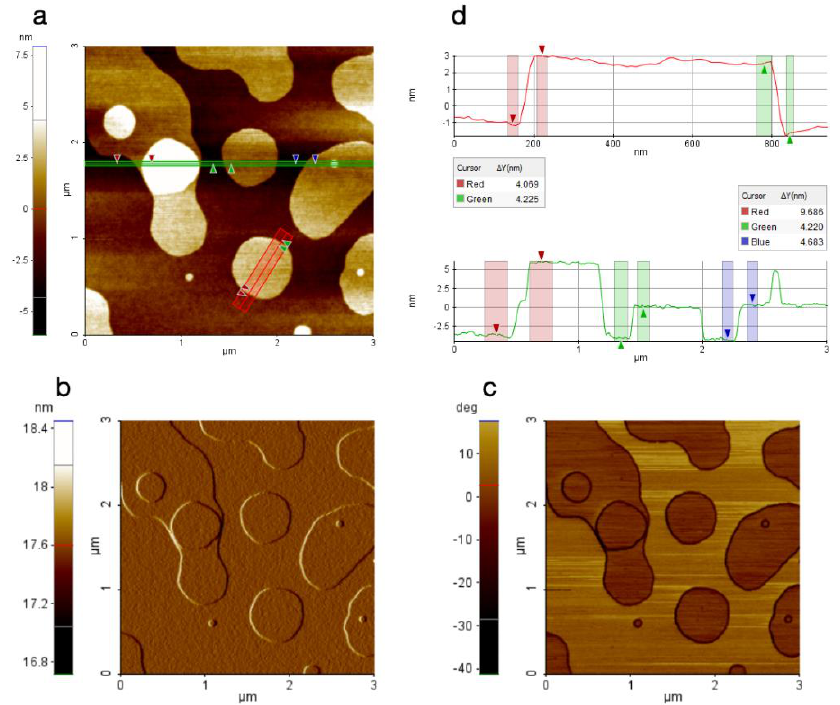
Figure 2. AFM image of AKV006 (DOPC) scanned at a location with a thin deposited lipid film, where ( a ) shows the topography data, ( b ) the amplitude signal, ( c ) the phase signal, and ( d ) the topography profile for the two lines drawn in the topography image.